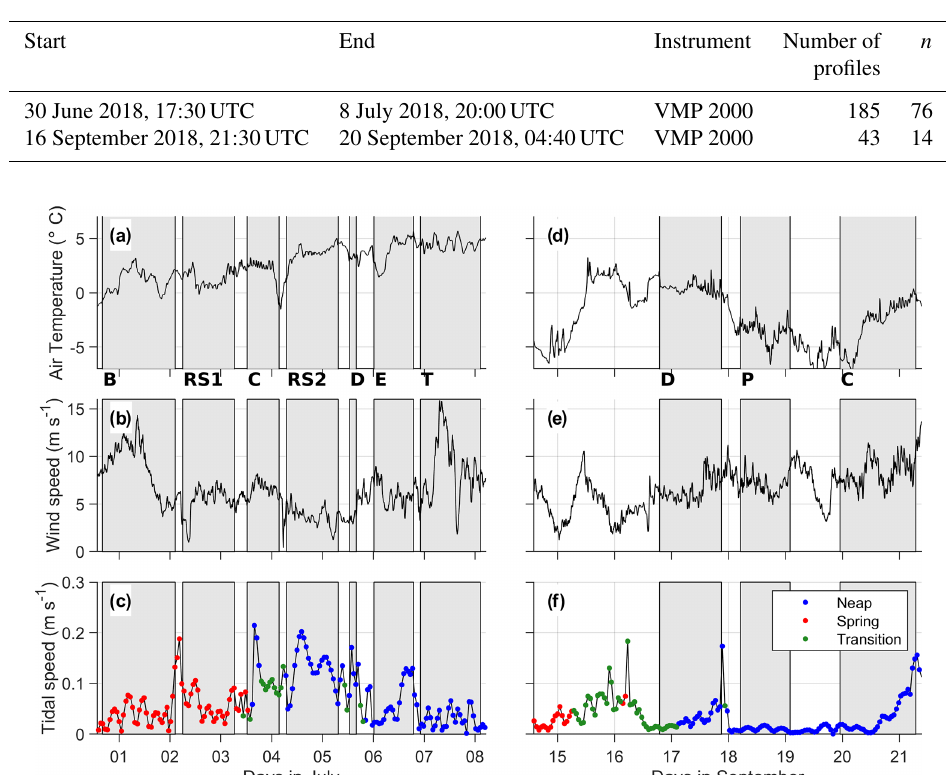
Figure 2. Air temperature (a, d) , wind speed (b, e) from the ship’s weather station and tidal current speed (c, f) from the Arc5km2018 model. Panels (a) – (c) are during the July (Summer) cruise. Panels (d) – (f) are during the September (fall) cruise. Grey shading corresponds to the periods of turbulence measurements (sections or process stations). In (c) and (f) , the tidal conditions during the time of sampling are indicated as neap, spring tide, and the transition between the neap and spring tide with blue, red and green dots